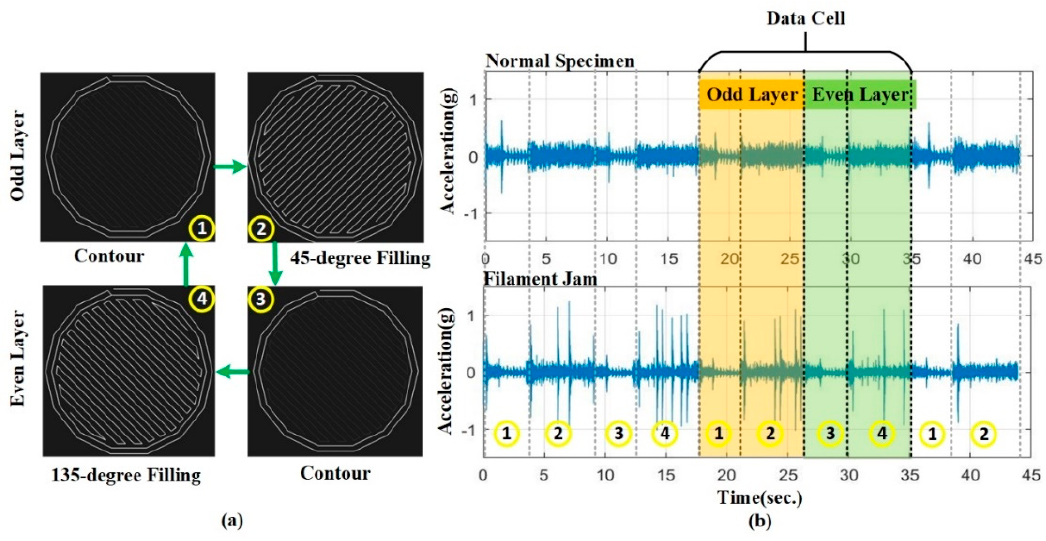
Figure 5. The basic working conditions and the length of the data cell: ( a ) the basic conditions; ( b ) the data cell and the signals for normal and filament jam states.